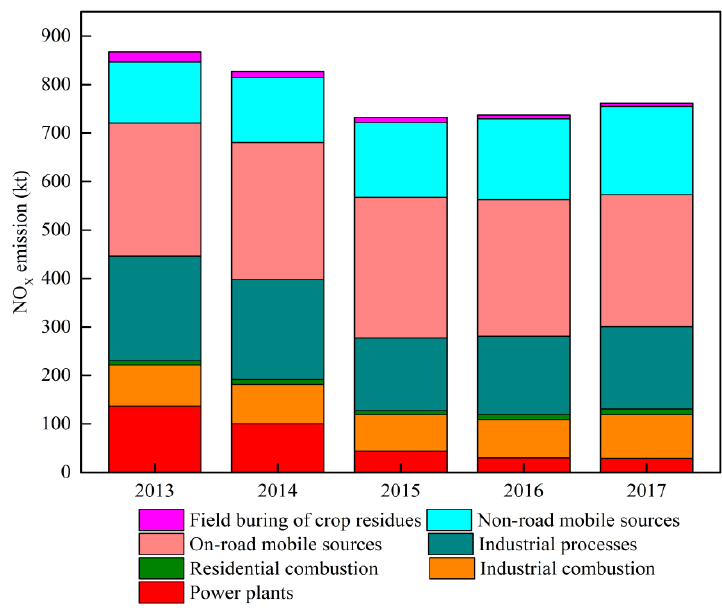
Figure 7. Changes in NO X emission in Sichuan during 2013–2017.